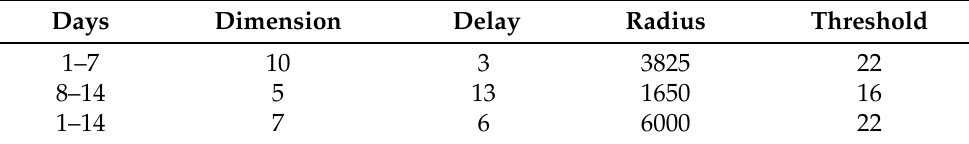
Table 13. Best parameters for coop2.